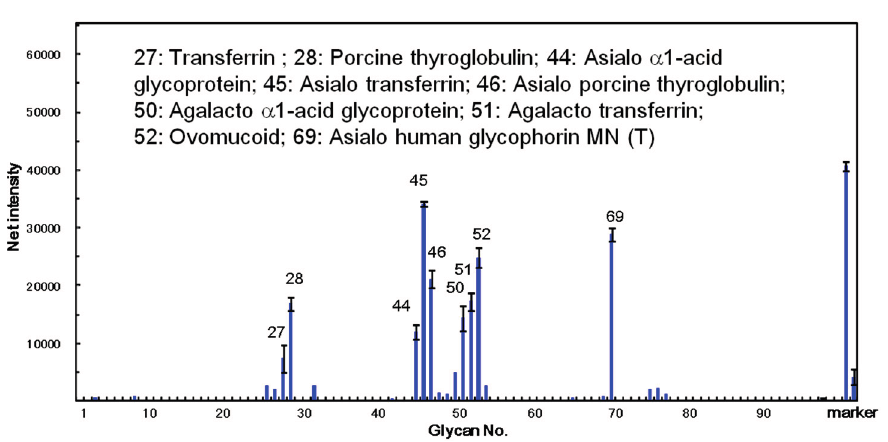
Figure 7. Specificity profiling of Apios tuber lectin (ATL). Scan images of ATL (12